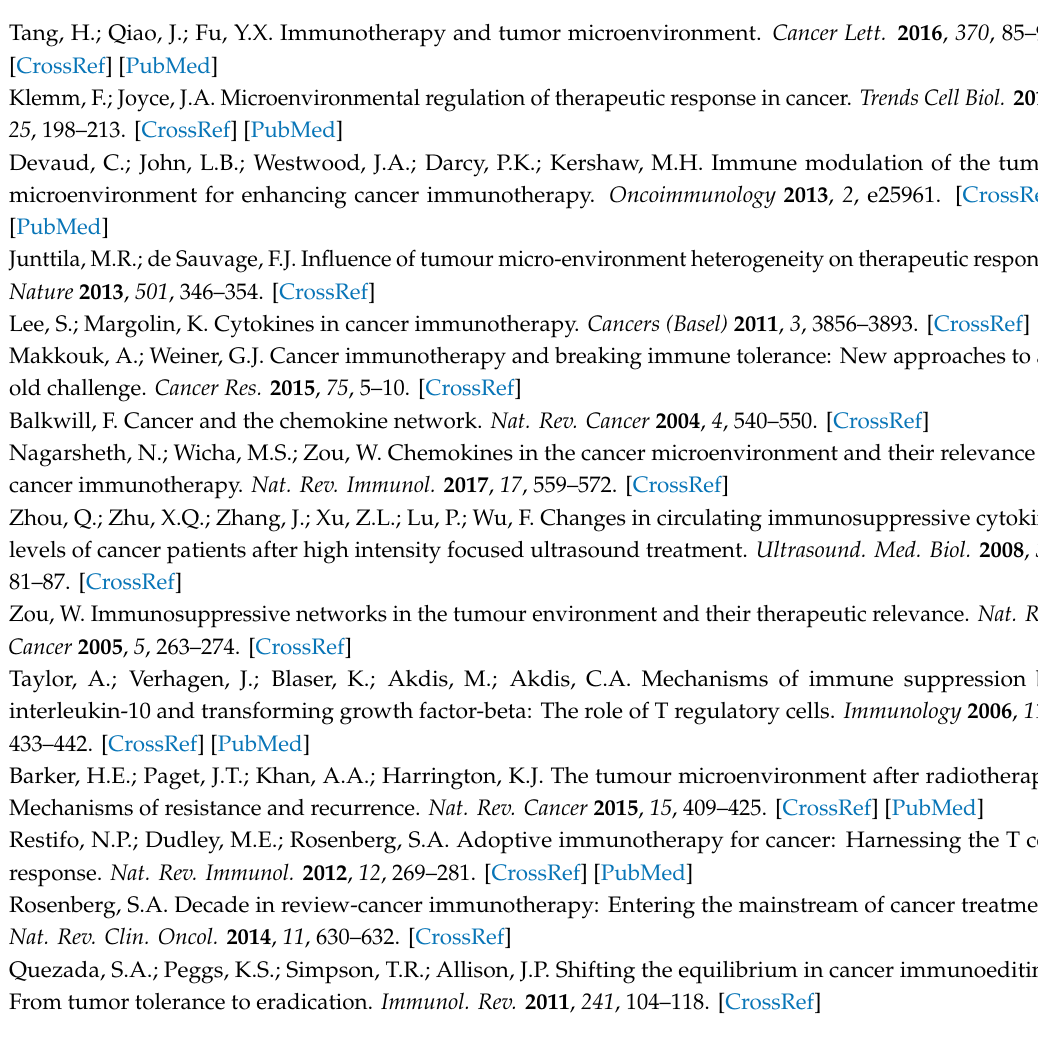
Figure S1: Quantitative values of CCTFs over time in mouse xenograft B16 melanoma tumor model. Figure S2: Quantitative values of CCTFs over time in mouse xenograft 4T1 breast cancer model. Figure S3: Immune cell profiles in B16 melanoma tumor-bearing mice 24 h following pFUS treatment on days 2, 6, or 10. Figure S4: Immune cell profiles in 4T1 tumor-bearing mice 24 h following pFUS treatment on days 2, 6, or 10. Figure S5: Quantitative values of CCTFs over time of B16 melanoma tumors dissected 24 h post-sonication on days 2, 6, or 10. Figure S6: Quantitative values of CCTFs over time of 4T1 breast cancer samples dissected 24 h post-sonication on days 2, 6, or 10. Table S1: Detailed list of